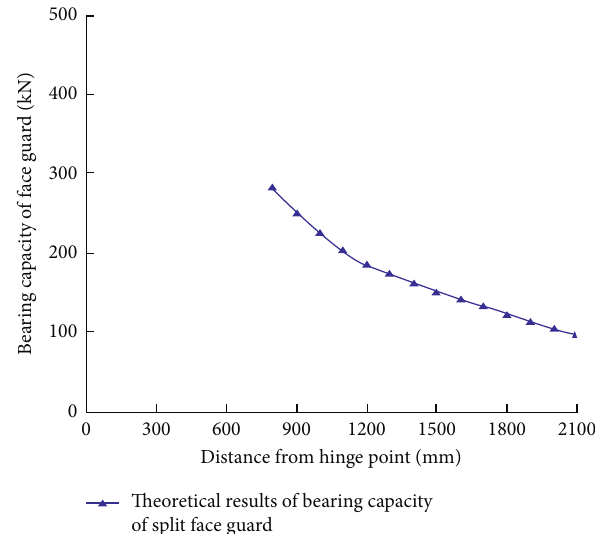
Figure 10: Theoretical value of the bearing capacity of the split face